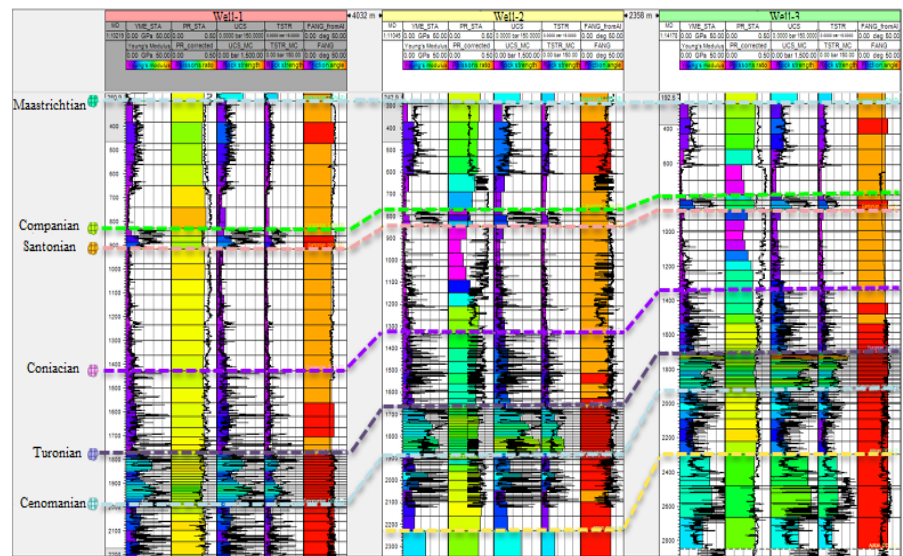
Figure 9. Rock properties calculated from seismic inversion results: ( a ) density (g/cm 3 ), ( b ) Young’s modulus (GPa), ( c ) Poisson ratio, ( d ) UCS (bar), ( e ) resistance to tension (bar), ( f ) friction region (deg).